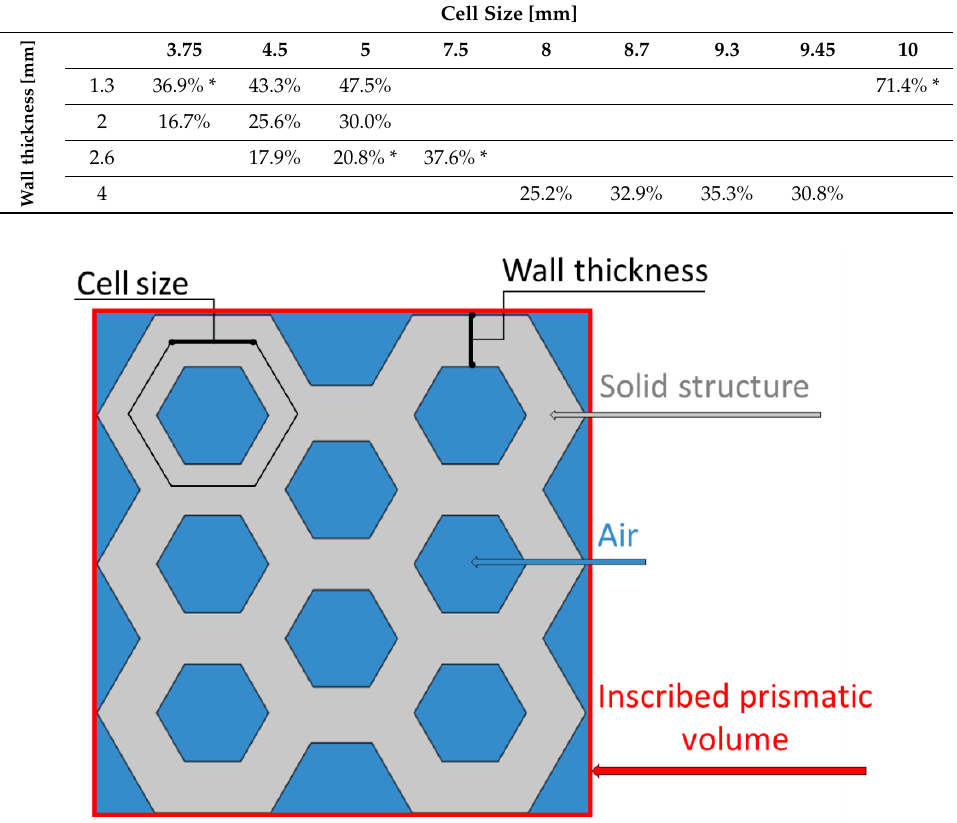
Figure 2. Cross-sectional view of the honeycomb structure with cell size of 7.5 mm and wall thickness of 2.6 mm. The structural features of the geometry are reported: the inscribed prismatic volume, air component, and solid structure are indicated in red, cyan, and grey, respectively. Porosity was computed as the air fraction relative to the inscribed prismatic volume.